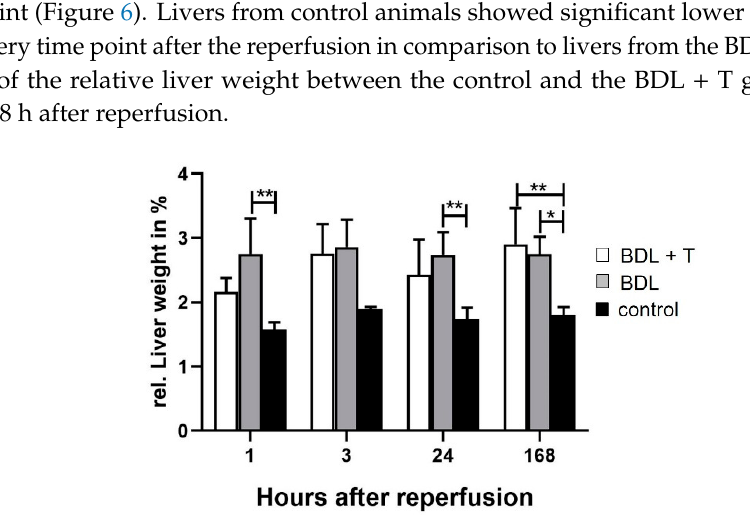
Figure 6. Changes at relative liver weight (in %) were evaluated in animals after 1, 3, 24, and 168 h after reperfusion in the BDL + T, BDL, and control group. Mean and standard deviation are shown in each group with significance levels of * p < 0.05 and ** p < 0.01.